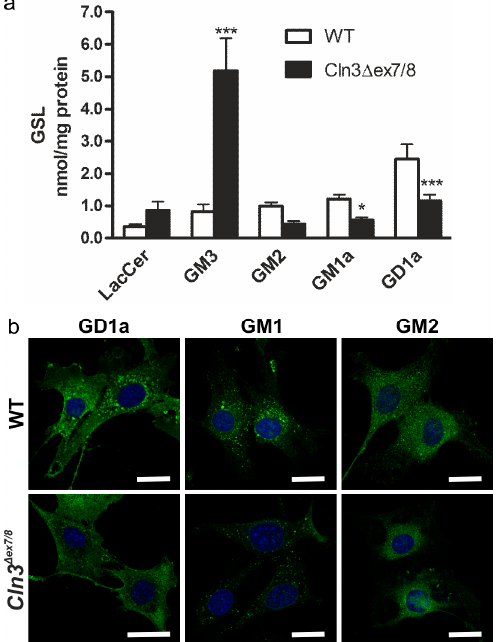
Figure 2. Alterations in gangliosides in the cerebellar precursor cells from the Cln3 Δ ex7/8 mouse model. ( a ) Quantitative HPLC analysis of glycosphingolipids in wildtype (WT) and Cln3 Δ ex7/8 cells shows increased levels of GM3, together with a reduction in GM1a and GD1a levels. Statistical analysis with 2-way ANOVA. p values * p < 0.05; *** p < 0.001; ( b ) Staining of GD1a, GM1a and GM2 in WT and Cln3 Δ ex7/8 cells. GM1a and GD1a levels are reduced in C ln3 Δ ex7/8 cells as compared with WT cells. The cells were immunostained with specific antibodies against the respective gangliosides and detected with a secondary antibody coupled to Alexa 488. Blue staining shows the nuclei stained with DAPI. Scale bar: 20 µm.